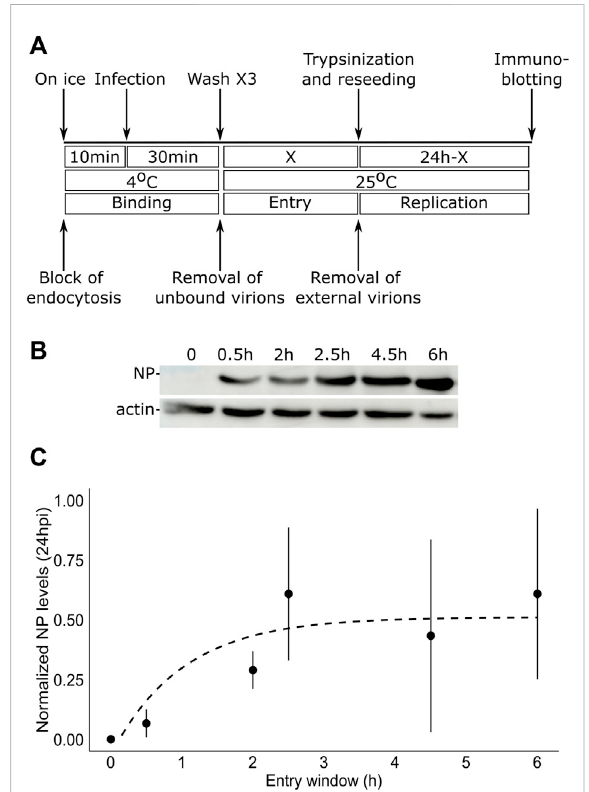
TiLVentrywindowintilapiacells. (A) Aschematictimelineand procedures used to determine the duration of TiLV entry into tilapia cells. ‘ X ’ represents the different times tested to allow TiLV entry. (B) Immunoblotting of NP and actin levels in TmB cells infected with TiLV for the indicated entry windows and extracted 24 hpi. (C) Quanti fi cation by densitometry of NP expression levels (normalized to actin levels) of three independent repeats of the experiment shown in (B) . The dashed line shows the exponential curve fi tting the data, calculated by RStudio software/geom_ smooth